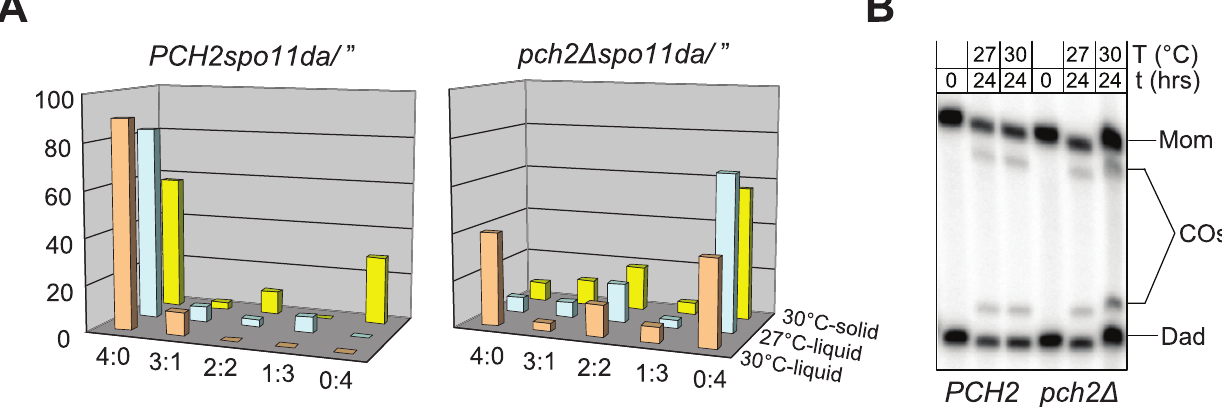
Figure 9. Spore viability and crossovers in pch2 D under different incubation conditions. (A) Spore viability patterns in PCH2spo11da/’’ (left) and pch2 D spo11da/’’ (right), undergoing meiosis at 30 u C (liquid medium), 27 u C (liquid medium), or 30 u C (solid medium). At least 30 tetrads were dissected under each condition. (B) Crossover levels at the HIS4LEU2 recombination hotspot. Meiotic cultures were split at t=0 hrs, and crossover levels were determined after incubation at 30 u C or 27 u C for 24 hrs. Asci from the same cultures were dissected to determine effects on spore viability (see